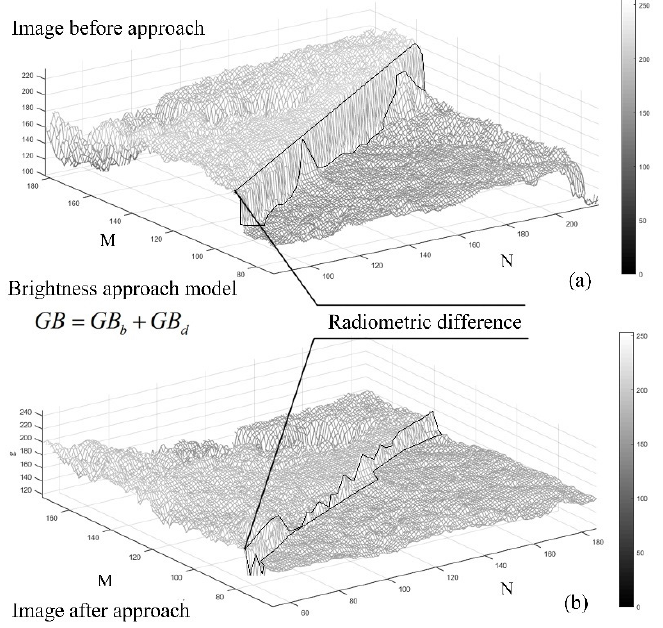
Figure 5. The principle of brightness approach. ( a ) Image before approach. ( b ) Image after ap- proach.